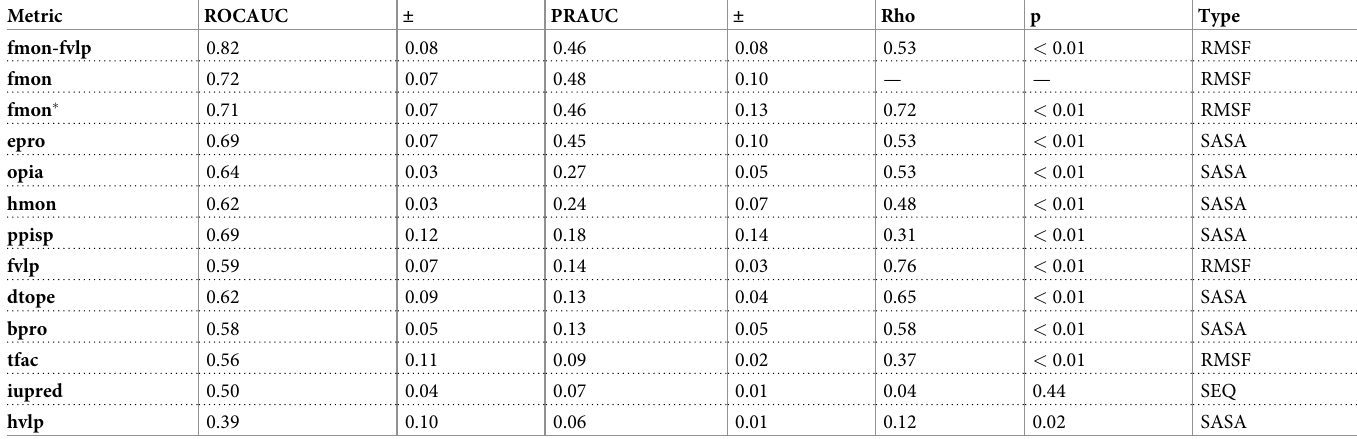
Table 2. Conserved epitope discovery performance